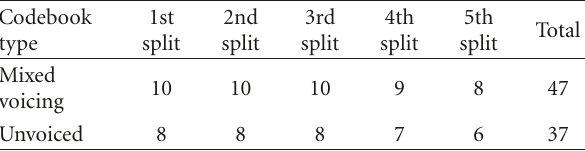
Table 1: Number of bits allocated to the SMQ